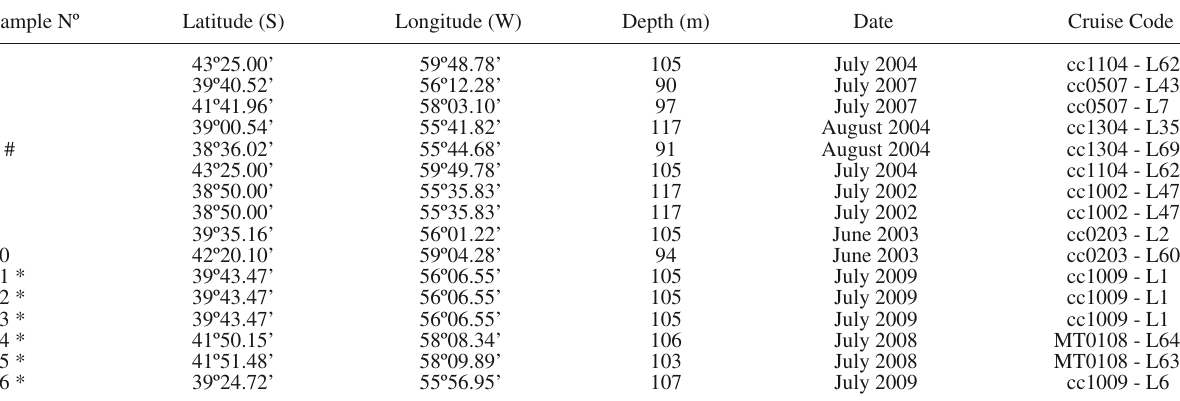
Table 1. – Location of the sampling sites of Mycale ( Aegogropila ) magellanica (Ridley, 1881). * Samples used for endofauna composition; # Northernmost record of the species. Sample